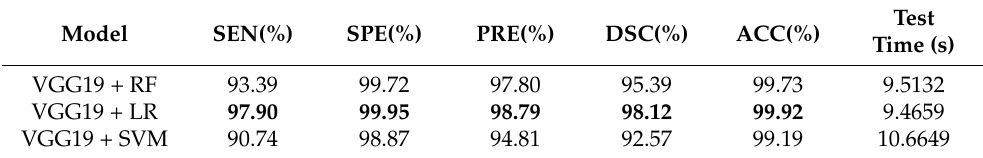
Table 5. The performance evaluation for VGG19 combined with different classifiers.